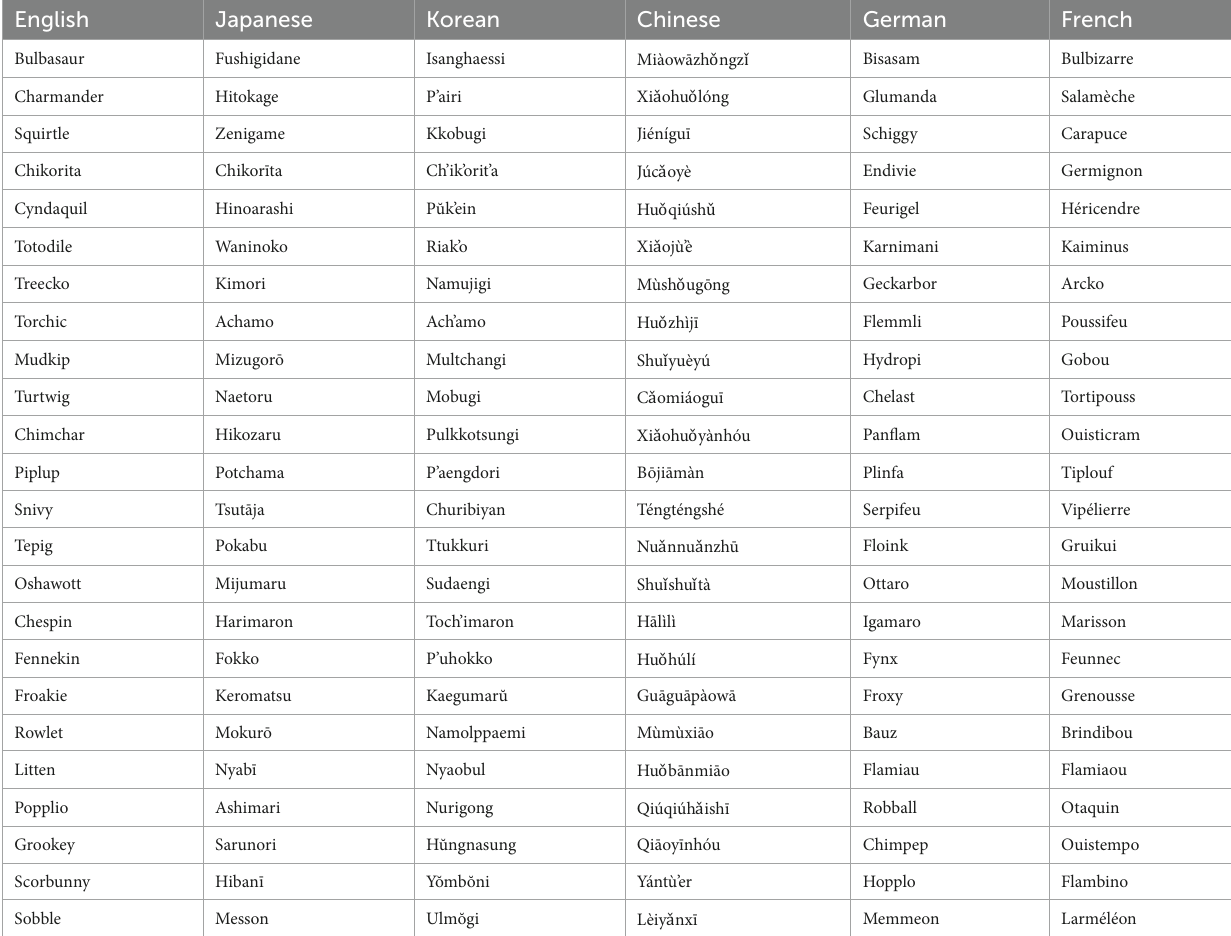
TABLE 2 List of each pre-evolution starter Pokémon from all 8 generations of the core Pokémon video games. English